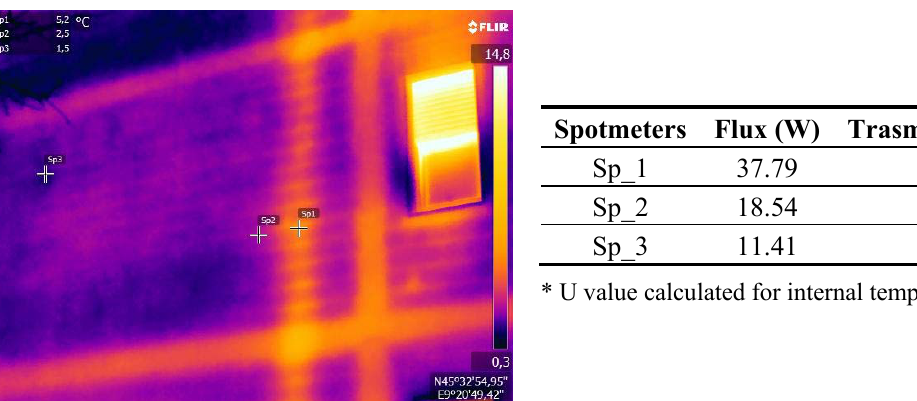
Table 5. Heat flow in a cavity wall.